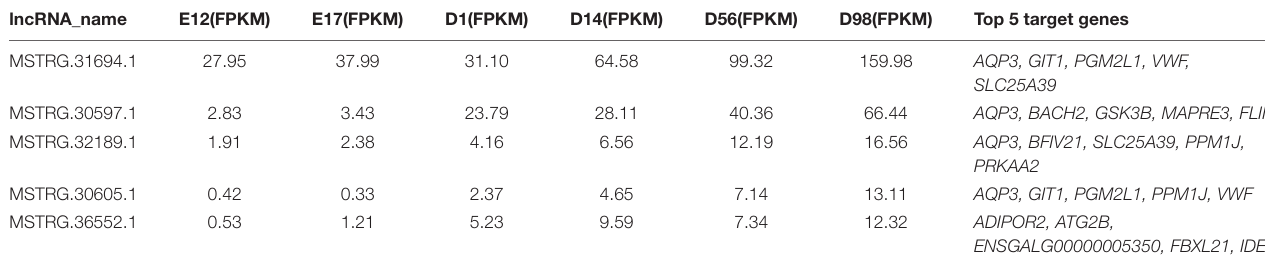
TABLE 2 | The top five differentially expressed lncRNAs and their target genes in profile